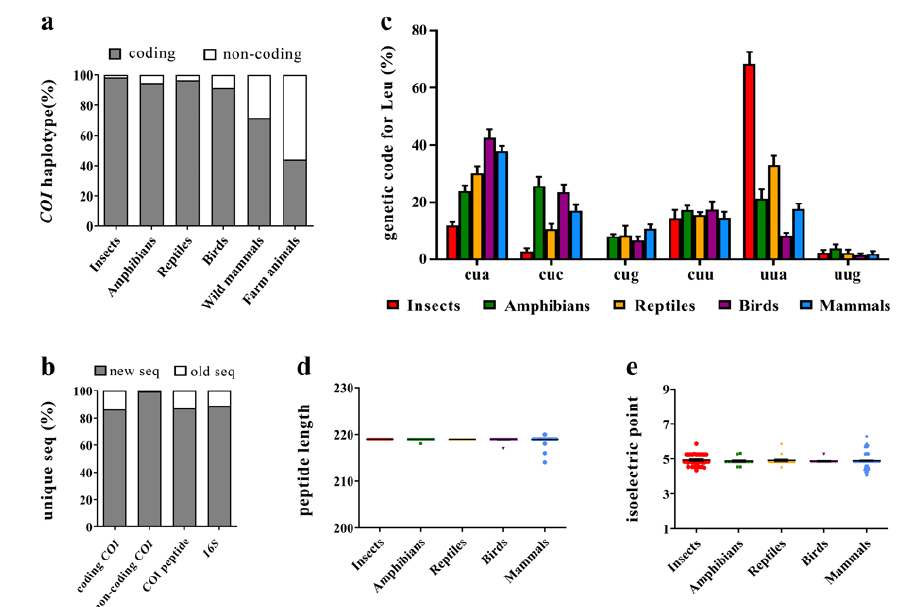
Figure 3. Isolation and characterization of COI peptides. (a) Translation of COI haplotypes using genetic codes for mitochondrial DNA among different animal groups as indicated. (b) Percentage of novel sequences (seq) identified after BLAST similarity search in Genbank. (c) Usage of synonymous codons for leucine in COI peptides. Animal classes are indicated by various colors. (d and e) Sequence length and isoelectric point of COI peptides. Each dot represents a unique protein